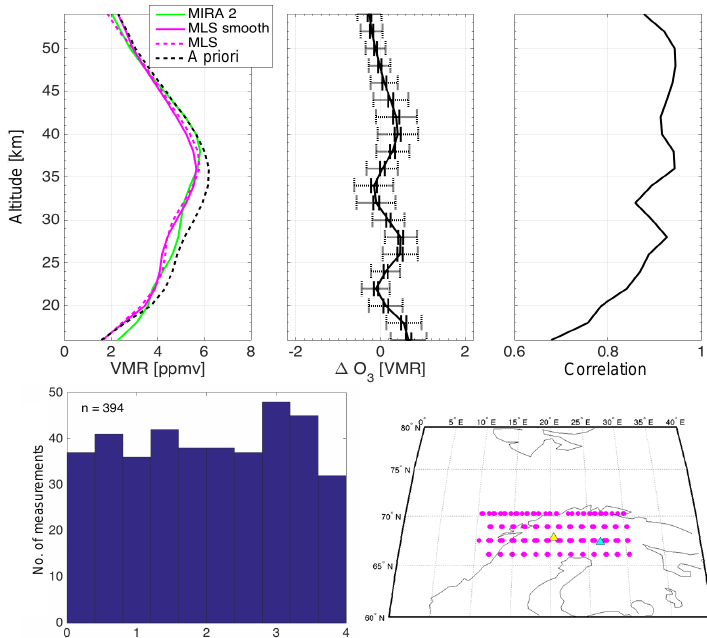
Figure 8. The same as Fig. 7 but for MIRA 2–MLS.